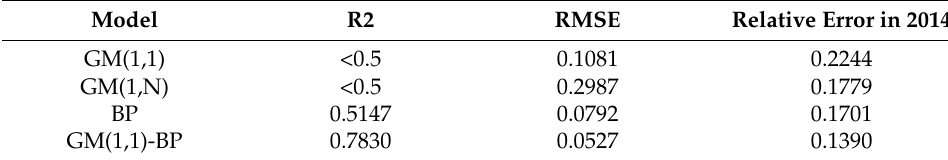
Table 2. Analysis of drug resistance prediction for the different